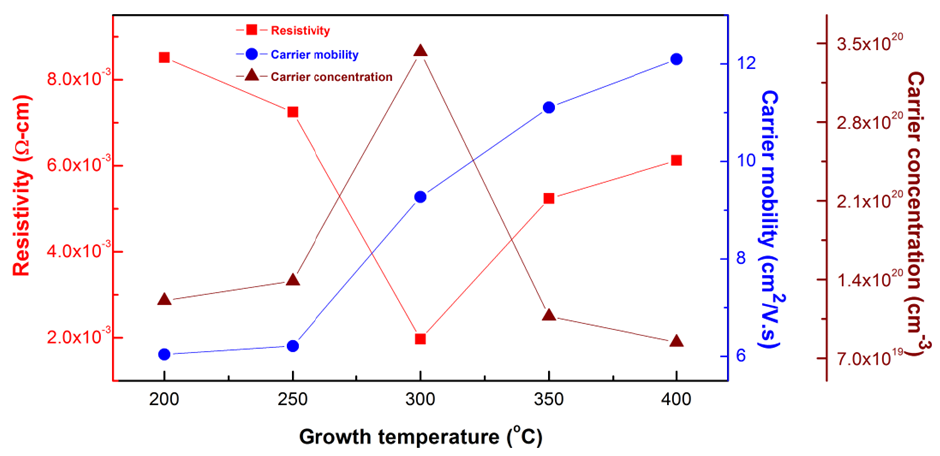
Figure 6. Electrical properties of 1.0 wt.% WZO films deposited at 200 – 400 °C.